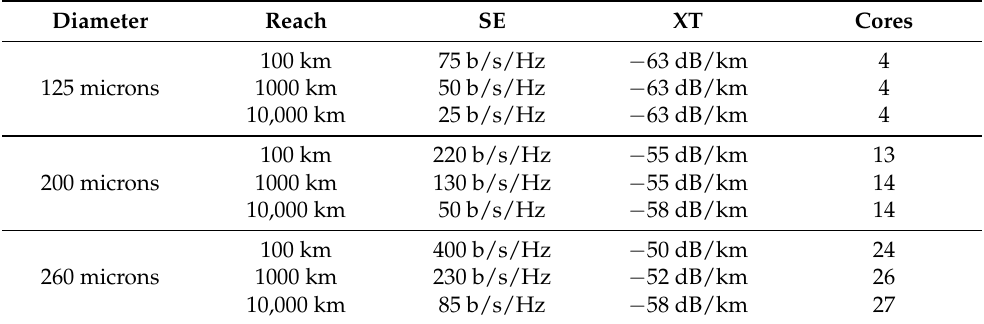
Table 3. Summary of experimental results from [73]. (Diameter: cladding diameter. Reach: trans- mission distance. SE: maximum aggregate spectral efficiency. XT: optimum aggregate multicore crosstalk. Cores: optimum number of